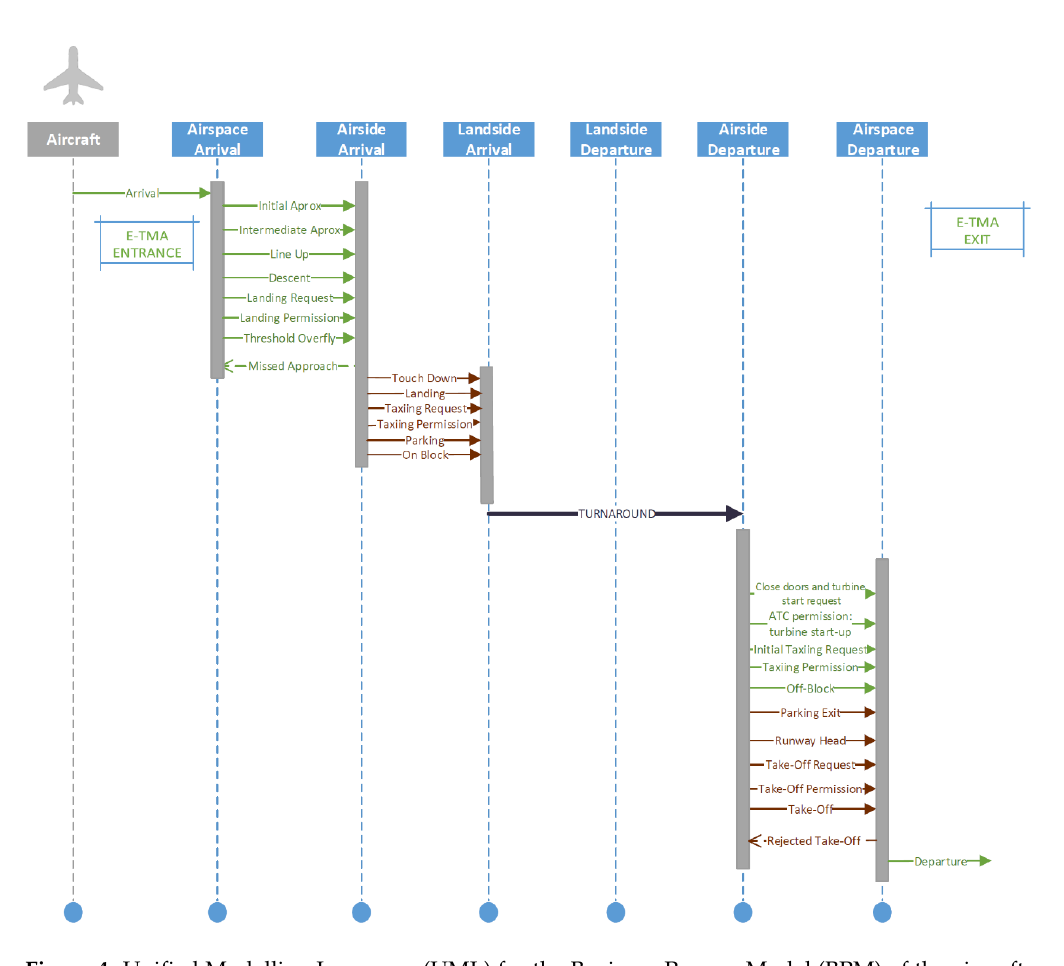
Figure 4. Unified Modelling Language (UML) for the Business Process Model (BPM) of the aircraft flow (airport/airspace integrated operations).